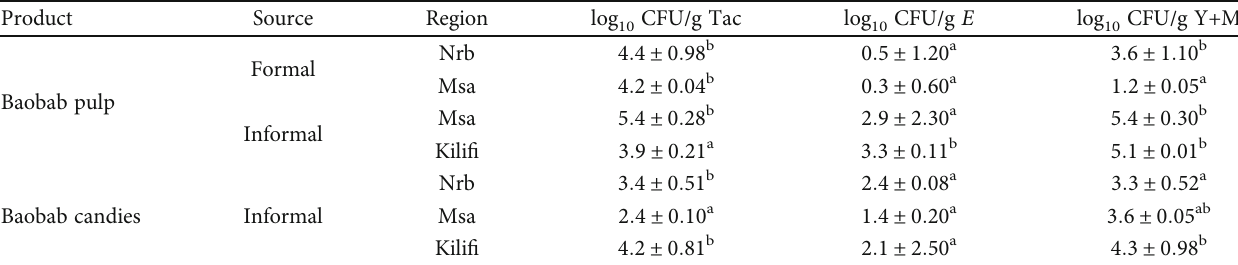
Table 2: Comparison of the microbial content of baobab products based on